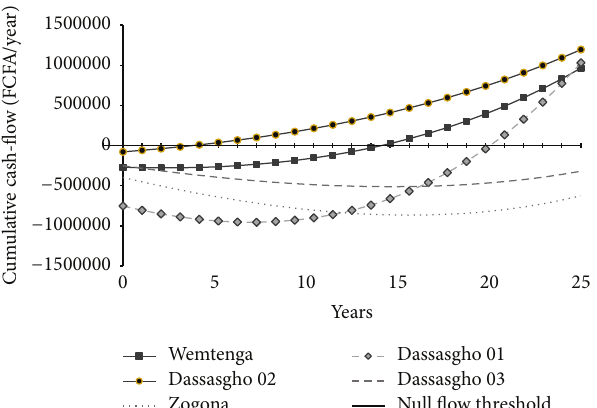
Figure5:Cumulativecash-flowssimulatedbyRETScreen.Notethat cash-flows from Zogona and Dassasgho 03 (in broken line) which use a domestic meter calibration of 3A are below null flow line.